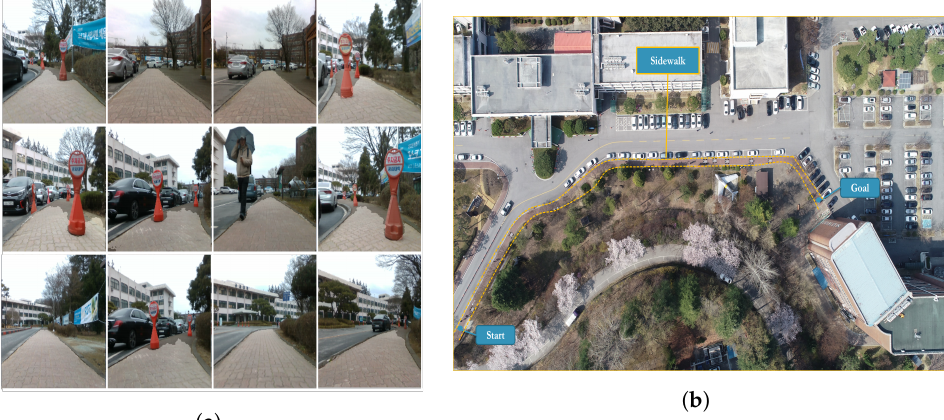
Figure 13. Zero-shot sim-to-real transfer: The segmentation model was deployed into a real robot. The robot performs autonomous navigation in real-world settings. ( a ) Examples of segmentation results on a real sidewalk. ( b ) Test site used for real-world experiments.